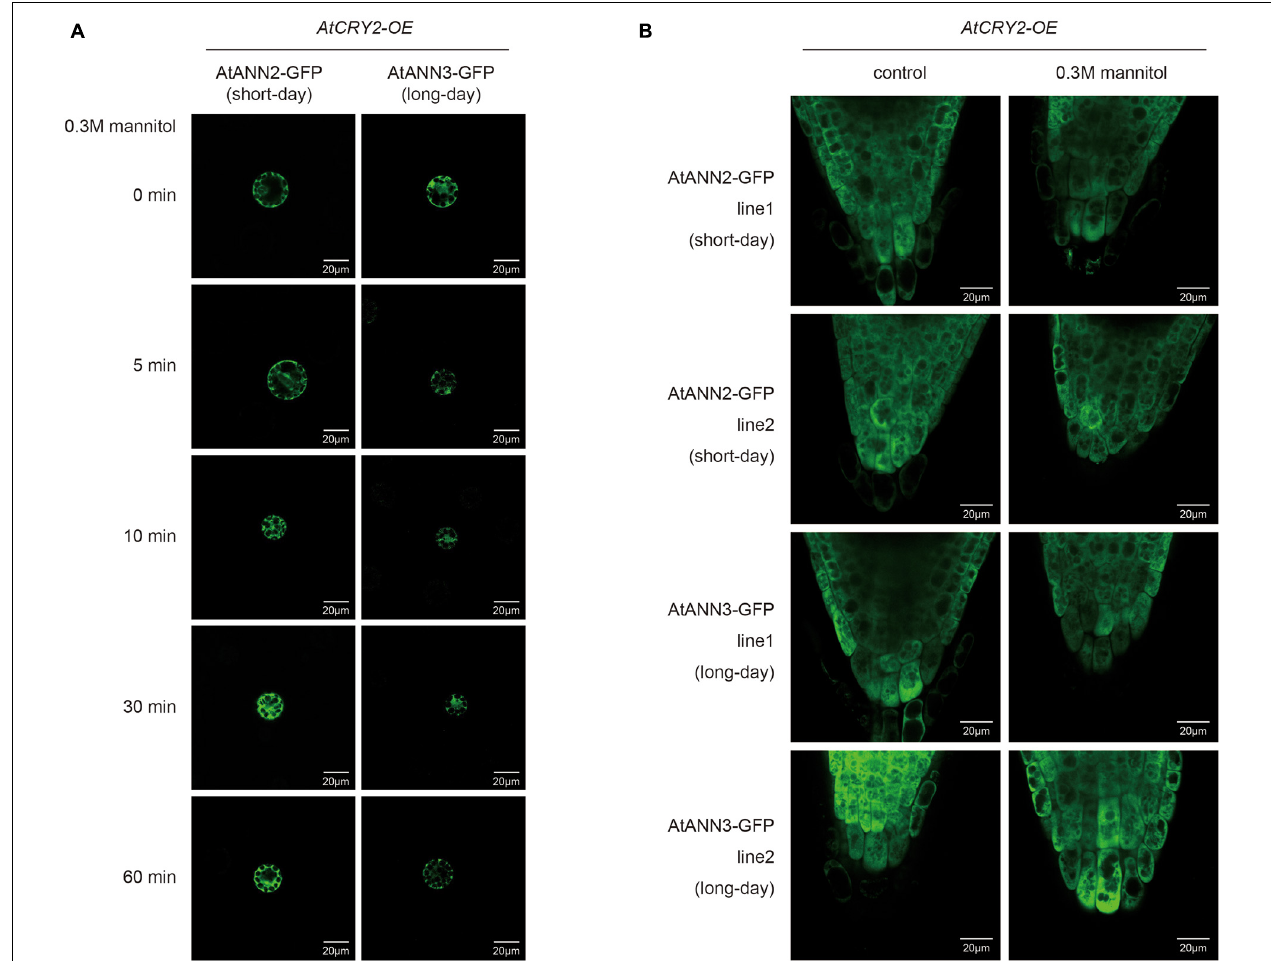
FIGURE 9 | AtCRY2 regulated subcellular location of AtANN2 and AtANN3 in response to mannitol treatment. (A) Subcellular localization of the AtANN2-GFP and AtANN3-GFP fusion proteins in response to mannitol treatment for 0, 5, 10, 30, and 60 min using leaf cell protoplasts of AtCRY2-OE plants grown under different photoperiodic conditions. Scale bar = 20 µ m. (B) Subcellular localization of AtANN2-GFP and AtANN3-GFP fusion proteins using the transgenic lines in the AtCRY2-OE background subjected to treatment the same as Figure 4B